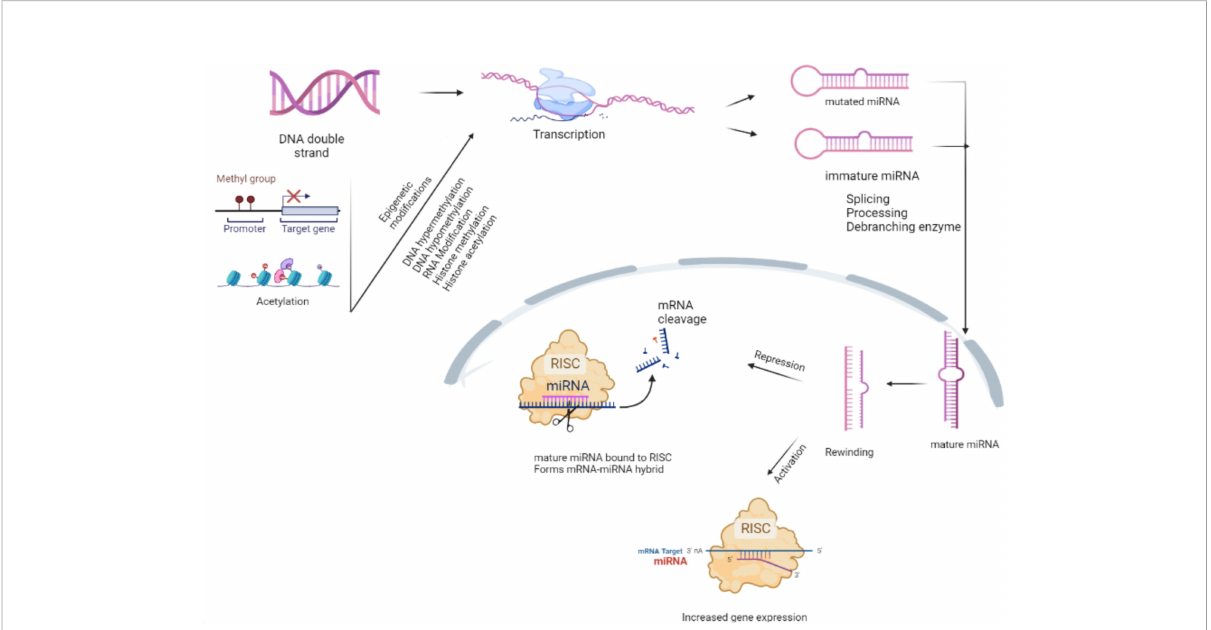
FIGURE 1 Maturation of microRNA (miRNA). RNA polymerase II or III modi fi es the primary miRNA into the cap structure through polyadenylation. The Drosha complex crops the miRNA into a hairpin-shaped pre-miRNA during the initial processing of pri-miRNA in the nucleus. Immature miRNA is exported to the cytoplasm by the exportin-5/Ran-GTP complex for Dicer processing. One of the miRNA duplex strands forms miRNA-RISC, which engages on the target mRNA to mediate gene silencing via translational repression or mRNA degradation/deadenylation (detailed in Figure 1). The epigenetic modi fi cations during the transcription process render the miRNA unable to carry out its normal functions. Messenger ribonucleic acid (mRNA); micro ribonucleic acid (miRNA); deoxyribo nucleic acid (DNA); RNA-induced silencing complex